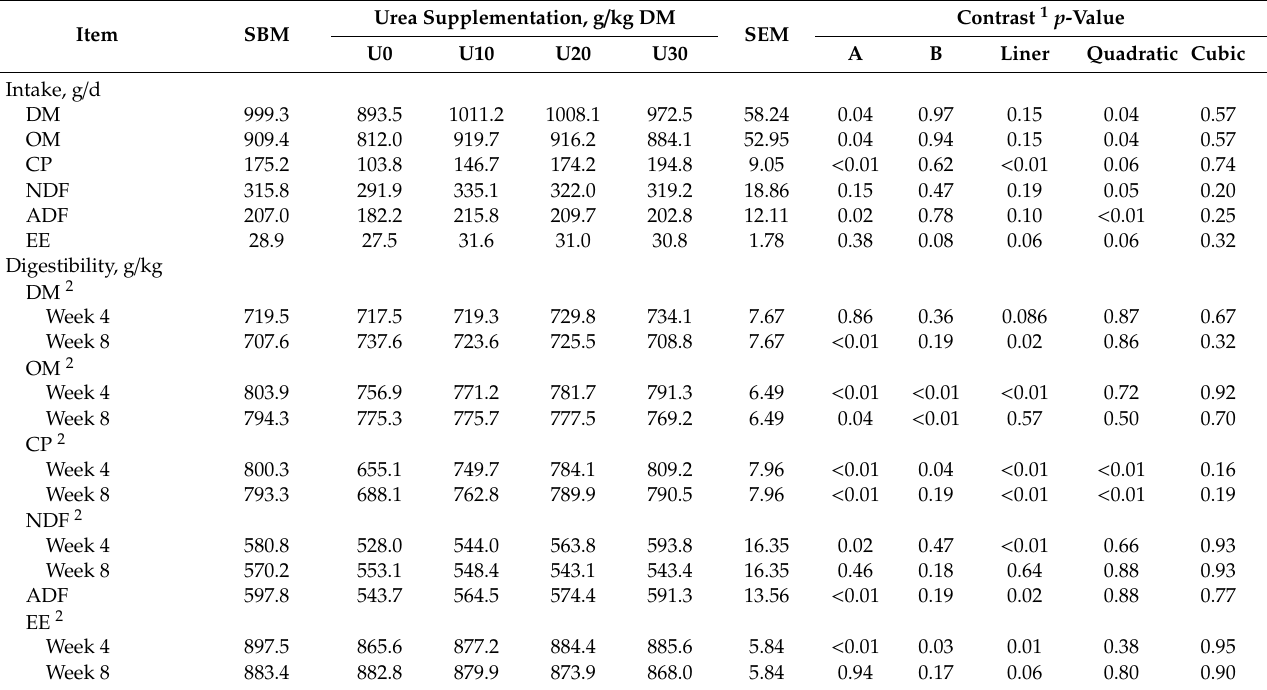
Table 3. E ff ects of urea supplementation on feed intake and apparent total tract digestibility of nutrients in fattening